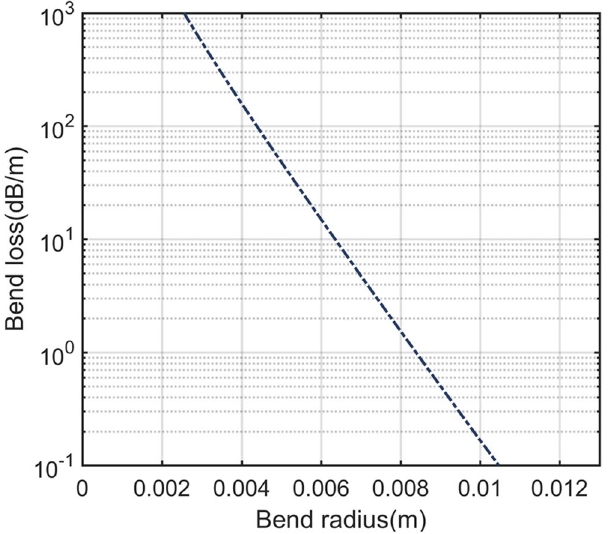
Figure 8. Analytically calculated loss using equation (4) of fundamental mode within the fiber core dip was